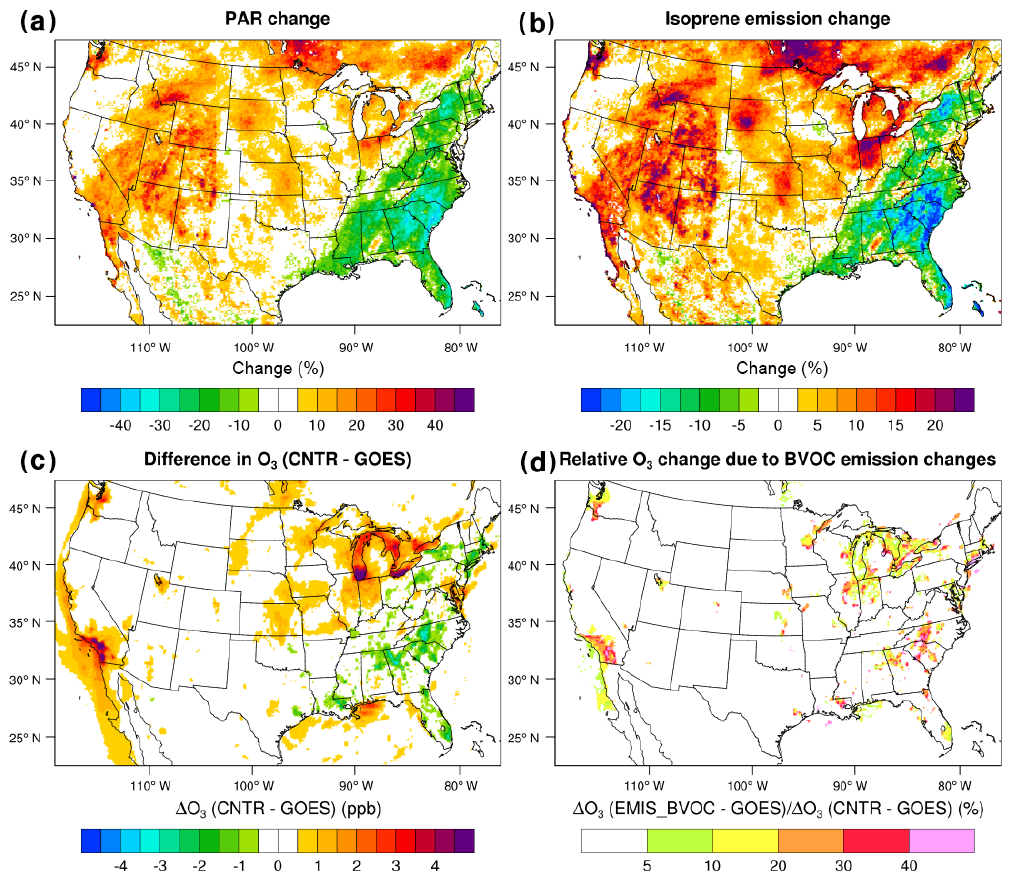
Figure 6. Spatial distributions of (a) PAR change and (b) isoprene emission change from biogenic sources between EMIS_BVOC and GOES simulations, (EMIS_BVOC–GOES)/GOES, averaged over the period of 3–12 July 2013. (c) Difference in O 3 between the CNTR and GOES simulations. (d) Ratio of O 3 difference between EMIS_BVOC and GOES simulations to O 3 difference between CNTR and GOES simulations, i.e., (cid:49) O 3 (EMIS_BVOC–GOES) /(cid:49) O 3 (CNTR–GOES). Note that the grids that have considerable O 3 difference between CNTR and GOES simulations ( > 1ppb) are depicted in (d)